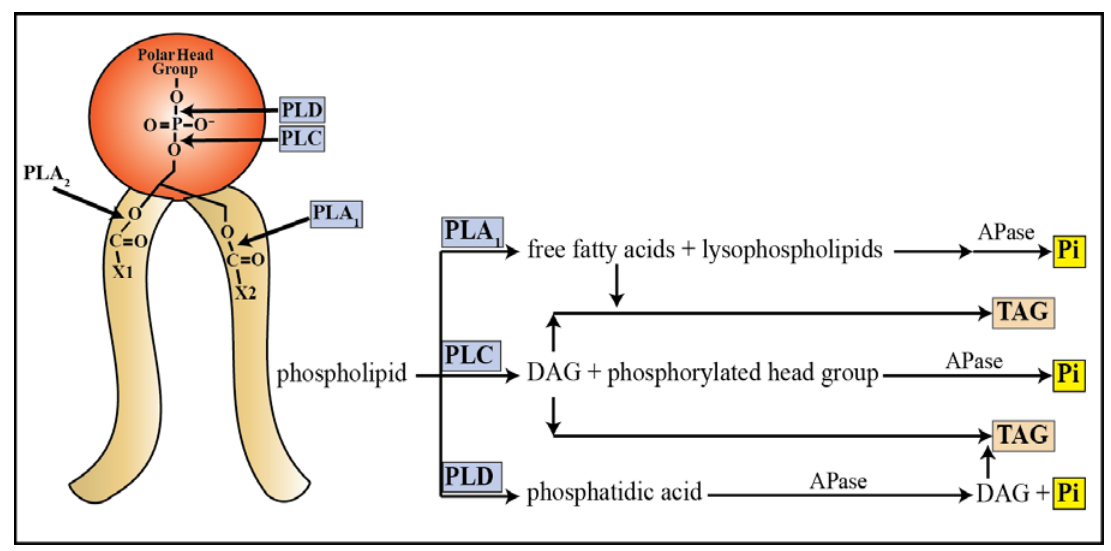
Figure 3. Model of glycerophospholipid degradation and Pi recycling by phospholipase enzymes. Enzymes belonging to the phospholipase A 1 (PLA 1 ), phospholipase C (PLC), and phospholipase D (PLD) groups have been implicated in recycling Pi during times of nutritional Pi-starvation or leaf senescence. DAG, diacylglyceride; TAG, triacylglyceride; X1 and X2, long chain fatty